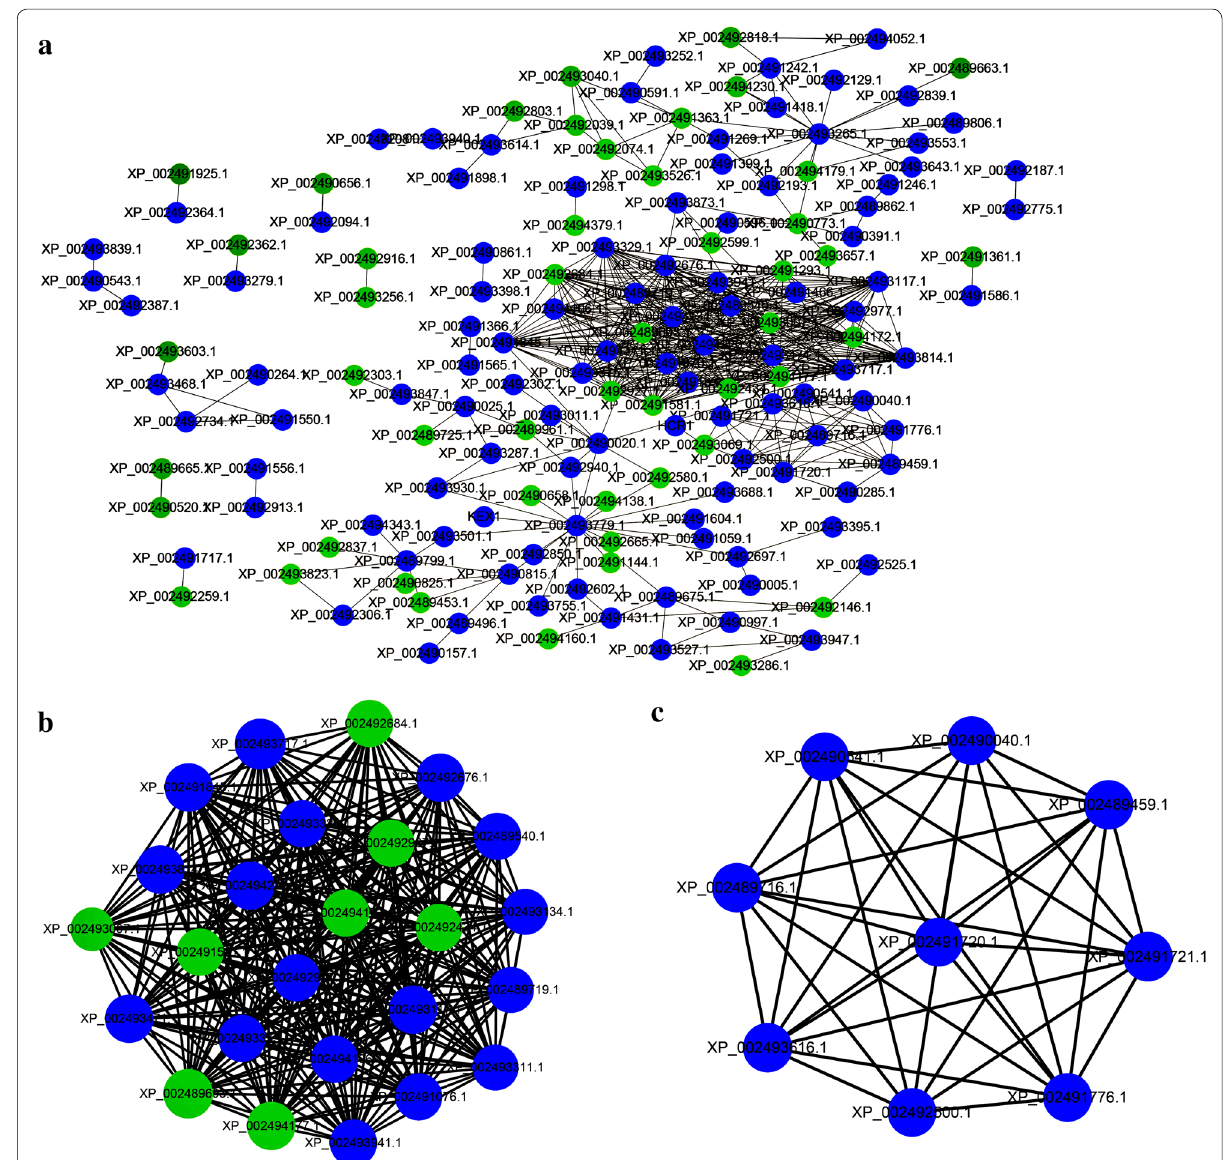
Fig. 5 Protein–protein interaction (PPI) network. a PPI network with midnight-blue and green-yellow modules. b , c Sub-networks of PPI network, genes indicated in blue color from midnight blue module, representing down-regulated genes, and genes indicated green color from green-yellow module, representing up-regulated